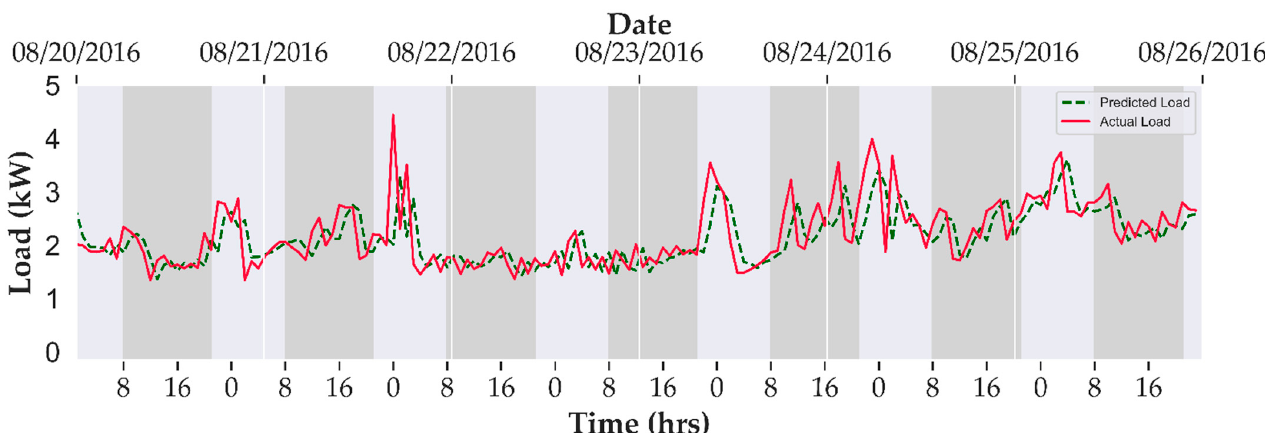
Figure 12. Load Forecasting for an extreme winter week.